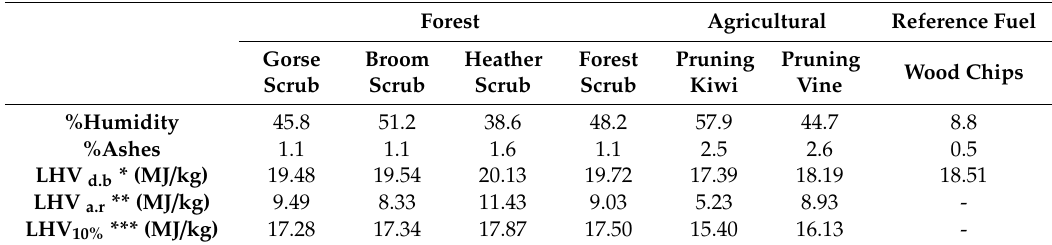
Table 2. Characterization of agroforestry biomasses studied.